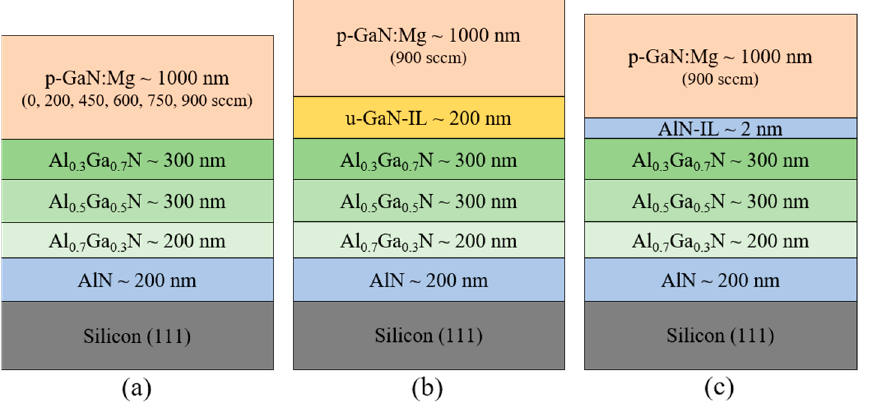
Figure 1. Schematic structures of p-GaN samples: ( a ) sample A with varying Cp 2 Mg flow rates (0, 200, 450, 600, 750, 900 sccm), ( b ) sample B with Cp 2 Mg 900 sccm and an additional 200 nm undoped GaN interlayer, and ( c ) sample C with Cp 2 Mg 900 sccm and a 2nm AlN interlayer.